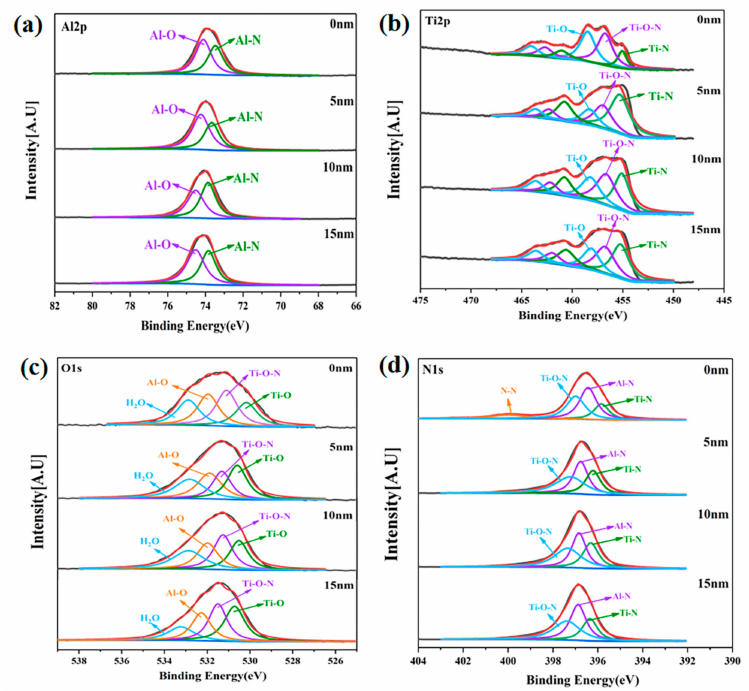
Figure 8. High-resolution XPS spectra of LPCVD-Ti 0.17 Al 0.83 N coating after immersion as a function of sputtering depth. ( a ) Al 2p; ( b ) Ti 2p; ( c ) O 1s; ( d ) N 1s.